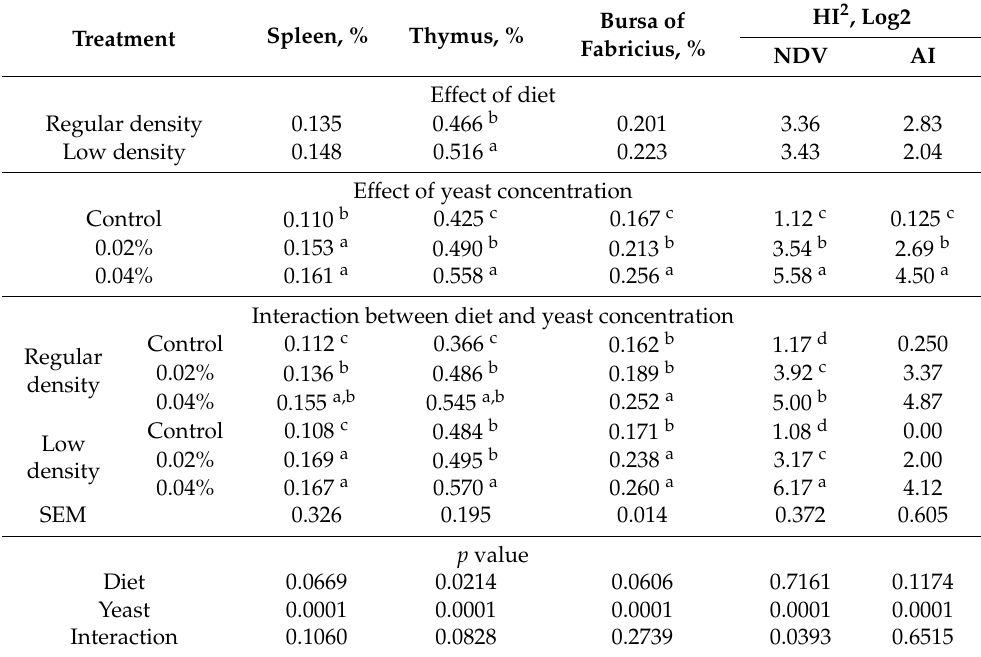
Table 6. Impact of different concentrations of Saccharomyces cerevisiae on immune organs and HI titer (log2) in response to avian influenza and Newcastle disease virus in 38-day-old broilers fed either a regular- or low-density diet from days 1 to 38 of age. Treatment Spleen, % Thymus, %